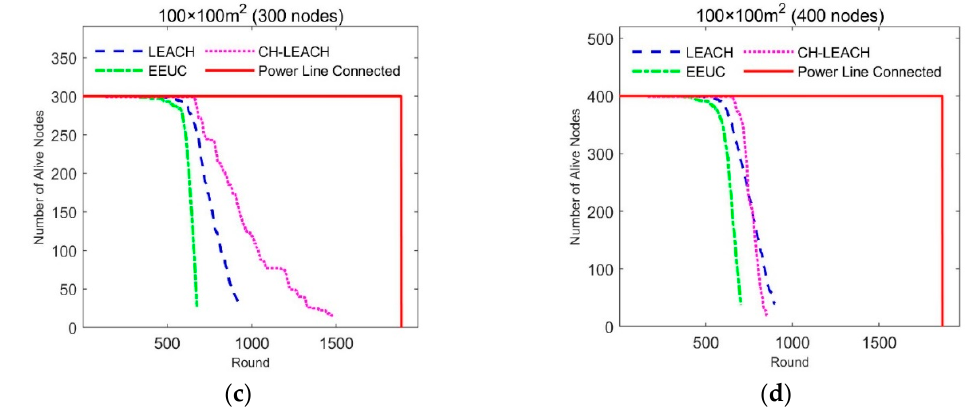
Figure 8. Simulation result, Relationship between node density and lifetime: ( a ) 100 × 100 m 2 (100 nodes), low density area; ( b ) 100 × 100 m 2 (200 nodes), middle density area; ( c ) 100 × 100 m 2 (300 nodes), high density area; ( d ) 100 × 100 m 2 (400 nodes), very high density area.